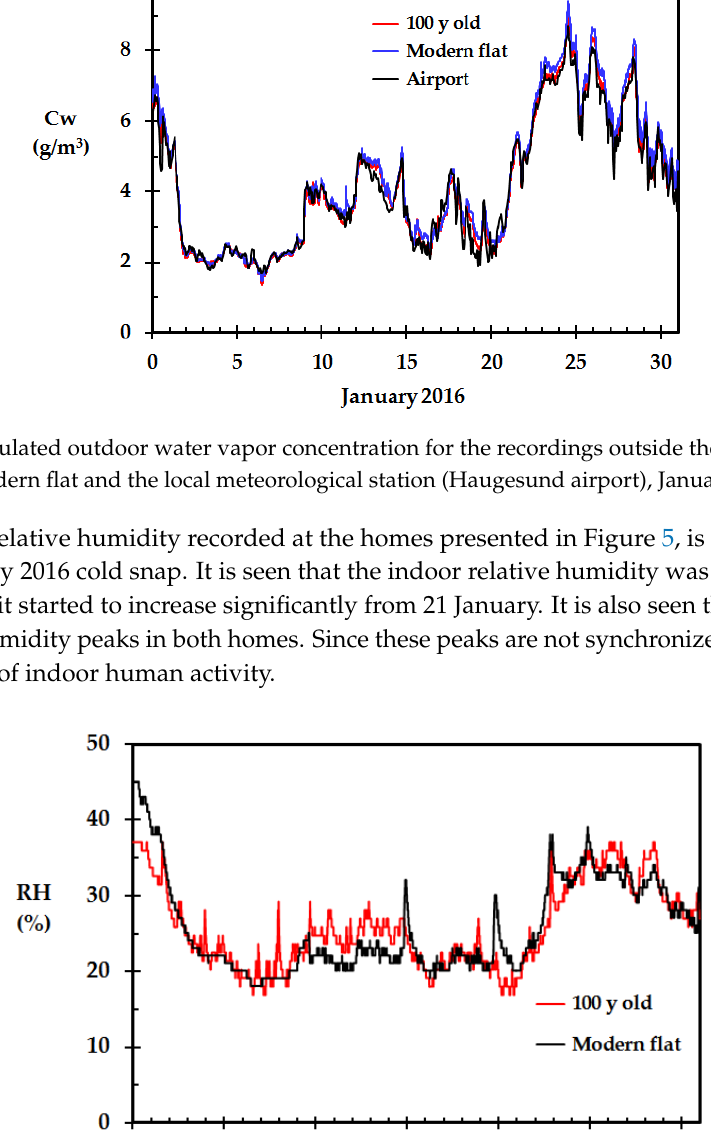
8 of 14 Figure 4. Recorded temperature and relative humidity at the local meteorological station (Haugesund airport), January 2016. The adiabatically heated dry subzero temperature air is easily identified in the first days of January. However, as both the temperature and the relative humidity vary, it is easier to interpret the data when studying the actual ambient air water concentration. The water vapor concentration calculated by Equations (1) and (2), based on the Netatmo